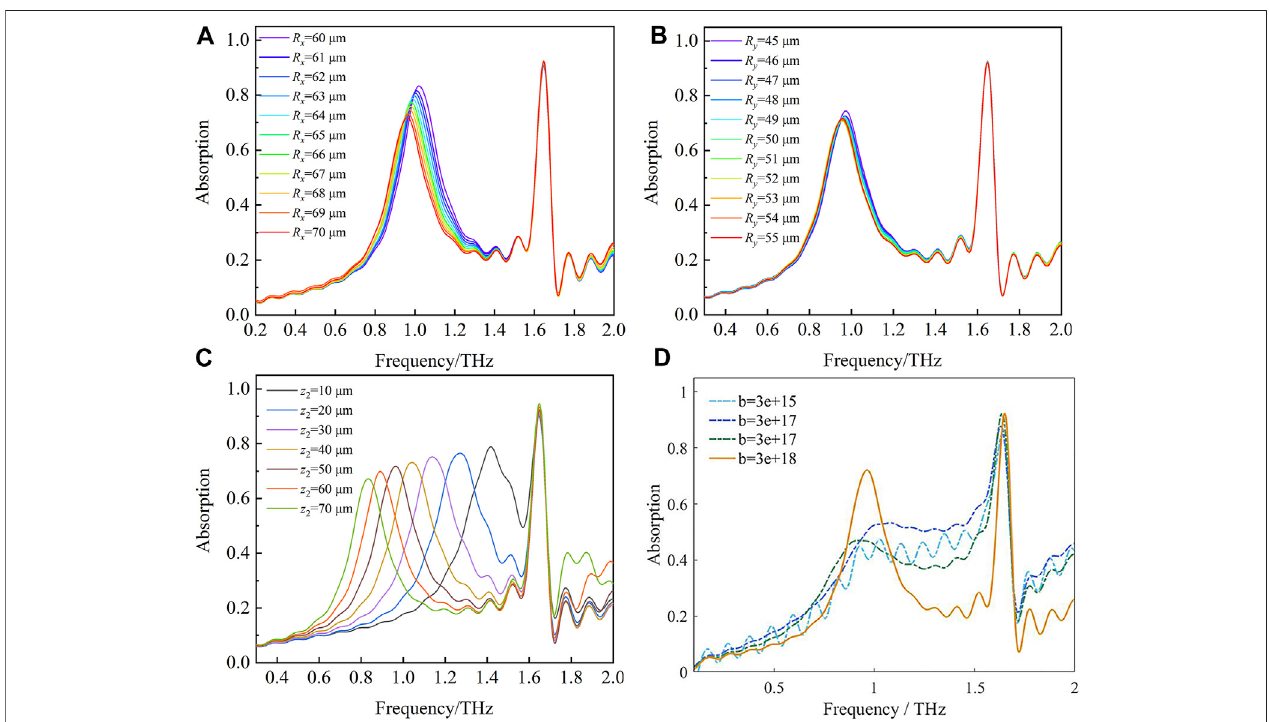
FIGURE 6 | (A) The absorption spectra with the major axis radius of the Si elliptic cylinder R x increasing from 60 to 70 μ m, where R y is fi xed as 50 µm. (B) The absorption spectra with the minor axis radius of the Si elliptic cylinder R y increasing from 45 to 55 μ m, where R x is fi xed as 70 µm. (C) The absorption spectra with different height of the elliptic cylinder z 2 . (D) The absorption spectra with different doping concentration of